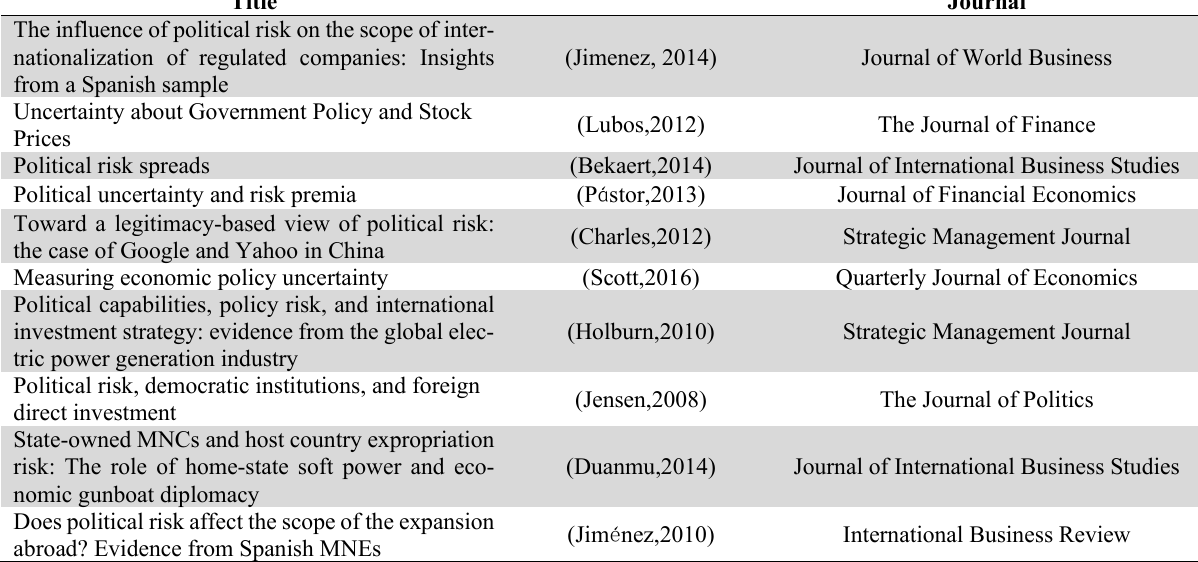
Top 10 cited pieces of literature in the field of political risk